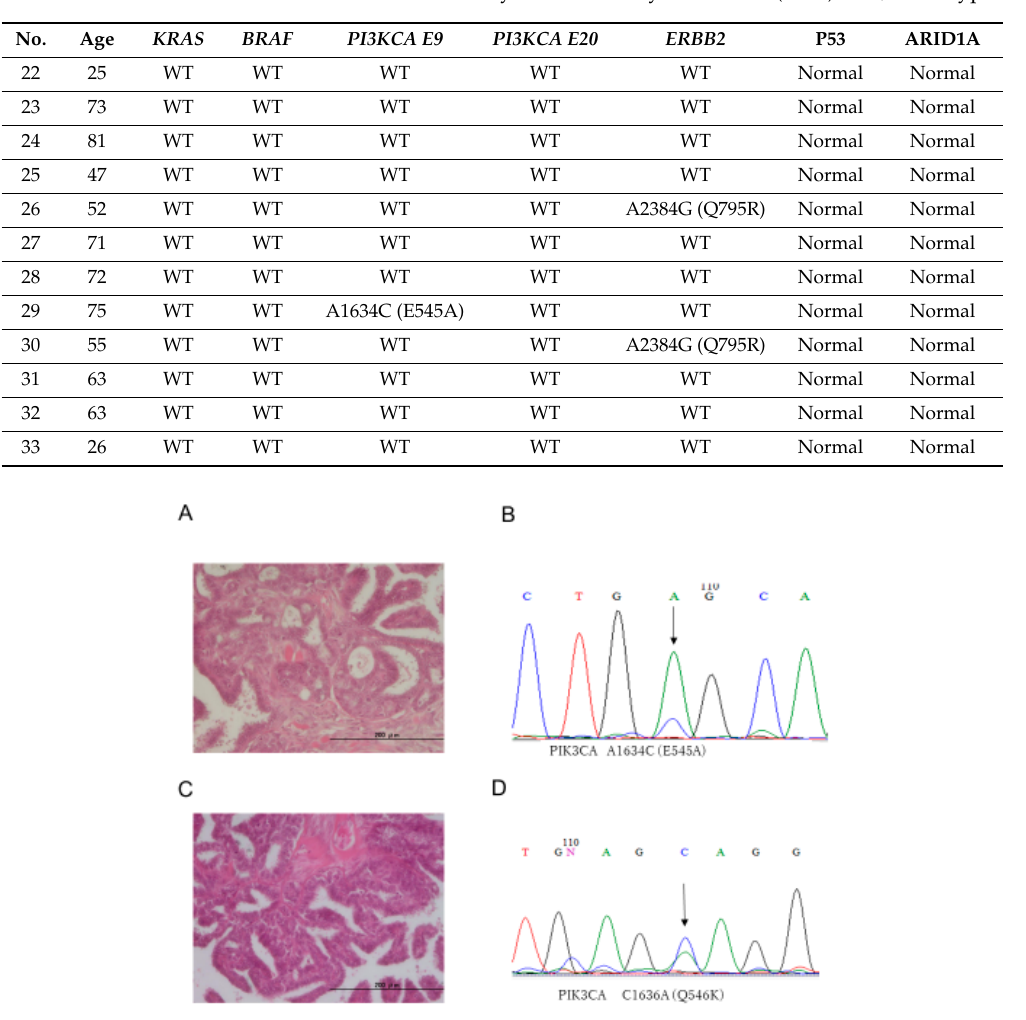
Figure 2. Representative positive staining of p53 ( A ) and ARID1A ( B ). Nuclear staining of p53 and ARID1A in an LGSC case.